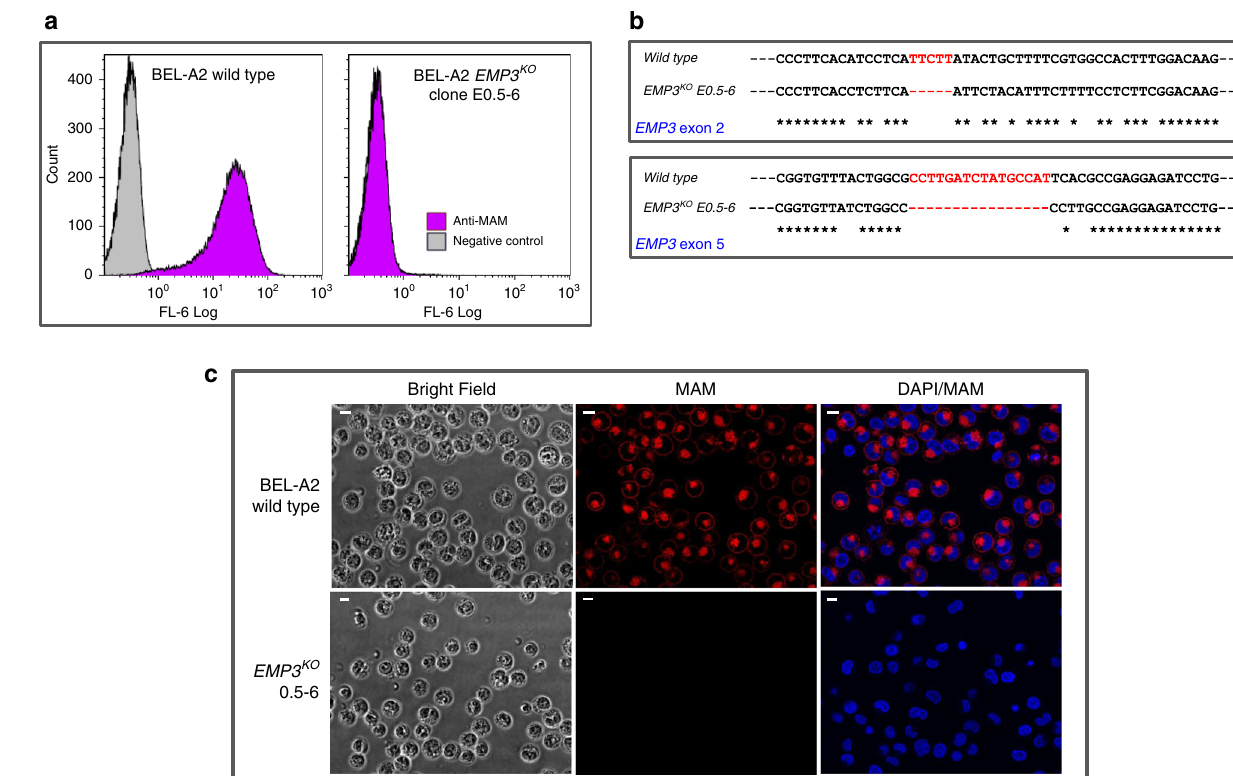
Fig. 2 Disruption of the EMP3 gene in BEL-A2 cell line demonstrated its underlying role in MAM antigen expression. a Flow cytometry analysis of EMP3 KO clone E0.5 – 6 with anti-MAM (P9 eluate). The CRISPR/Cas9-mediated gene editing system was used to disrupt EMP3 in BEL-A2 immortalised erythroid cell line. A total of eight transgenic BEL-A2 transfectant clones had no detectable MAM on cell surfaces, revealing the EMP3 gene to be responsible for MAM expression. b Sanger sequencing of EMP3 exons 2 and 5 for EMP3 KO clone E0.5 – 6. Sanger sequencing con fi rmed inactivating deletions in all KO clones, in EMP3 exon 2 and exon 5. In clone E0.5 – 6, deletions NM_001425.2: c.44_48del in exon 2 and NM_001425.2: c.344_359del in exon 5 were close to the location of guide DNAs and both would have introduced a reading frame shift and aberrant termination of the protein translation (p.Ile15AsnfsTer40 and p.Ala115ValfsTer176, respectively). c Immuno fl uorescence assay with BEL-A2 EMP3 KO clone E0.5 – 6. Four KO clones were stained with anti-MAM (P9 eluate; shown in red), with duplication, for immuno fl uorescence assays (magni fi cation ×40) to show a complete loss of MAM on their cell surfaces in all clones. DAPI staining shown in blue. Scale bars are 10 µ m. Several KO clones were also stained with commercially available anti-EMP3, as shown in Supplementary Fig.